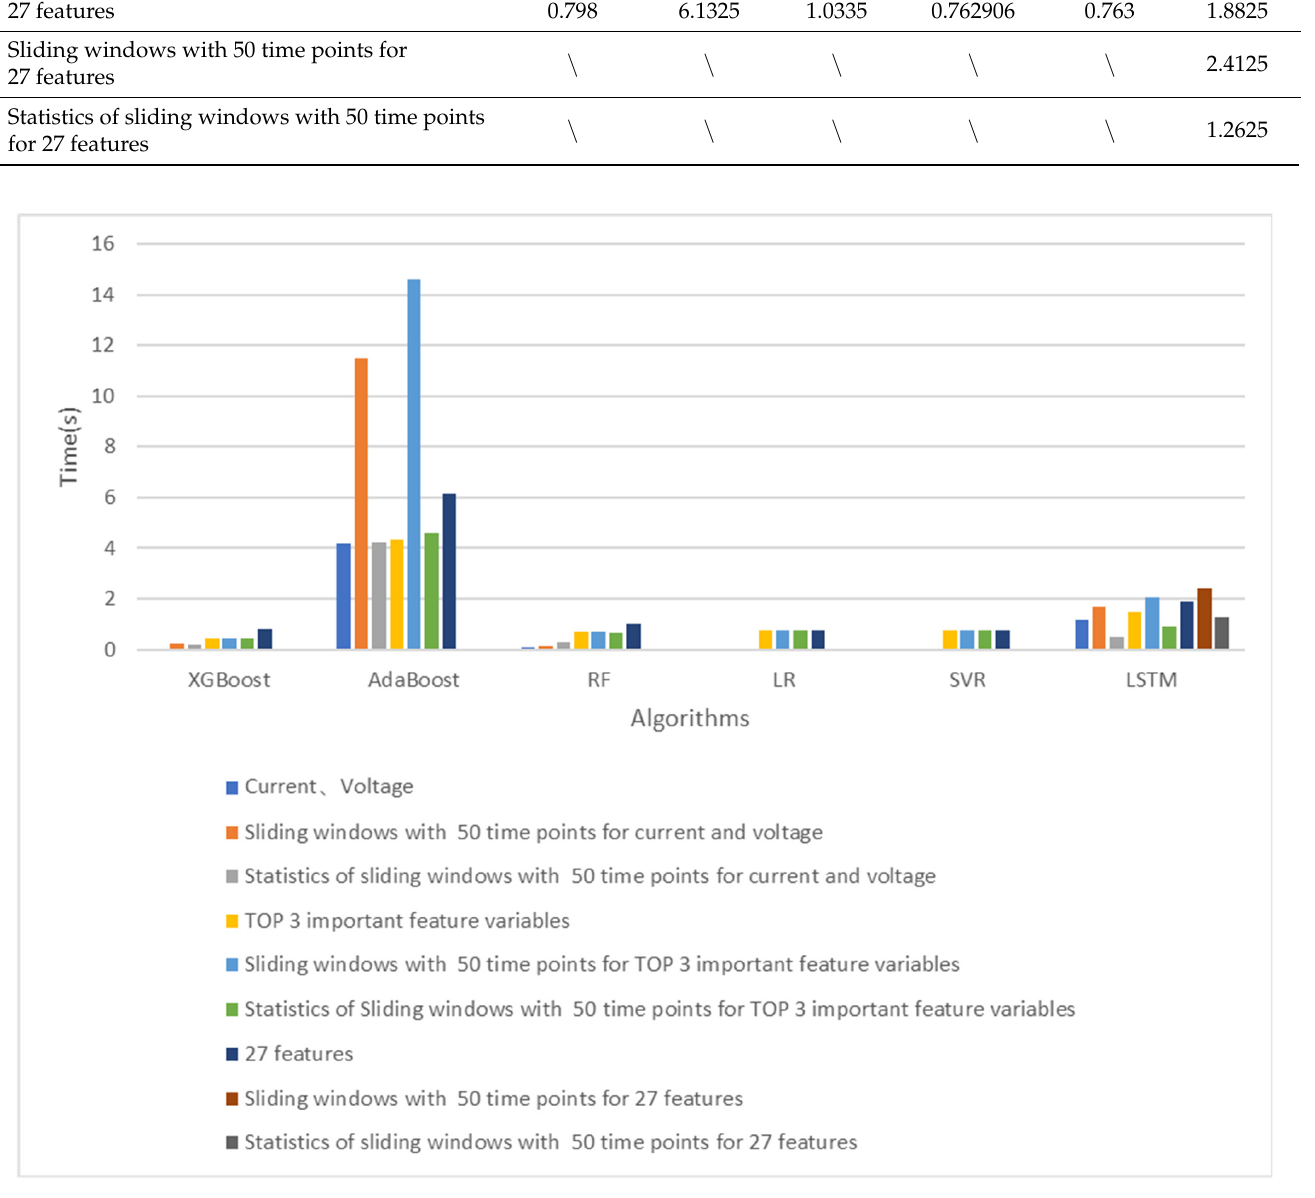
Figure 7. Total time consumption comparison of integrated algorithms for test set data (all).